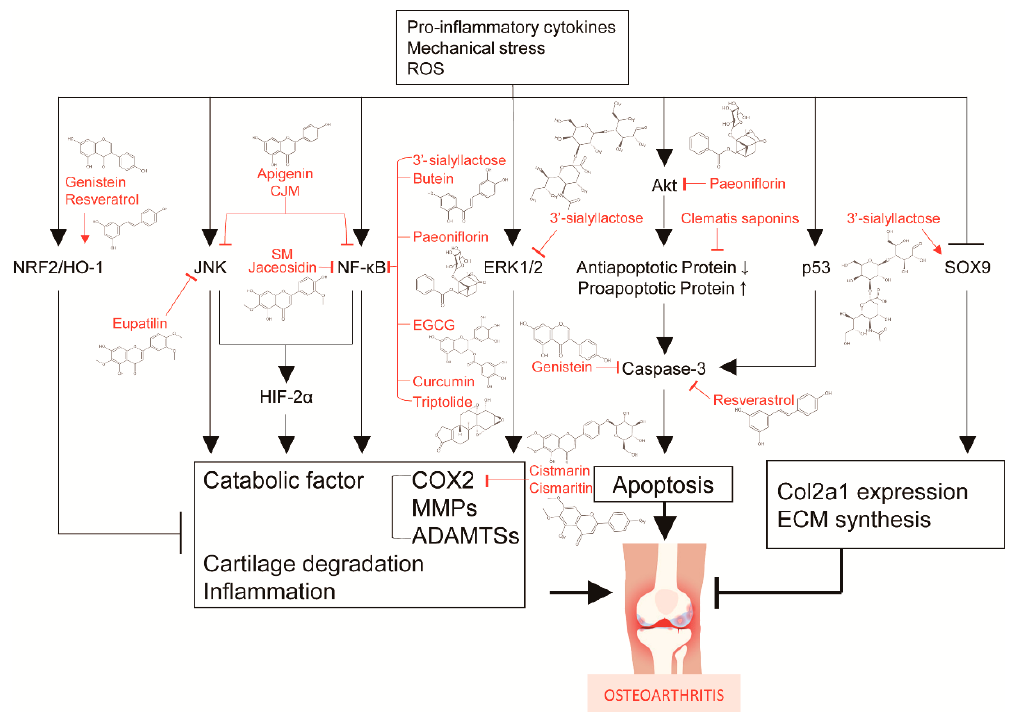
Figure 5. Mechanisms of action of single compounds against osteoarthritis.